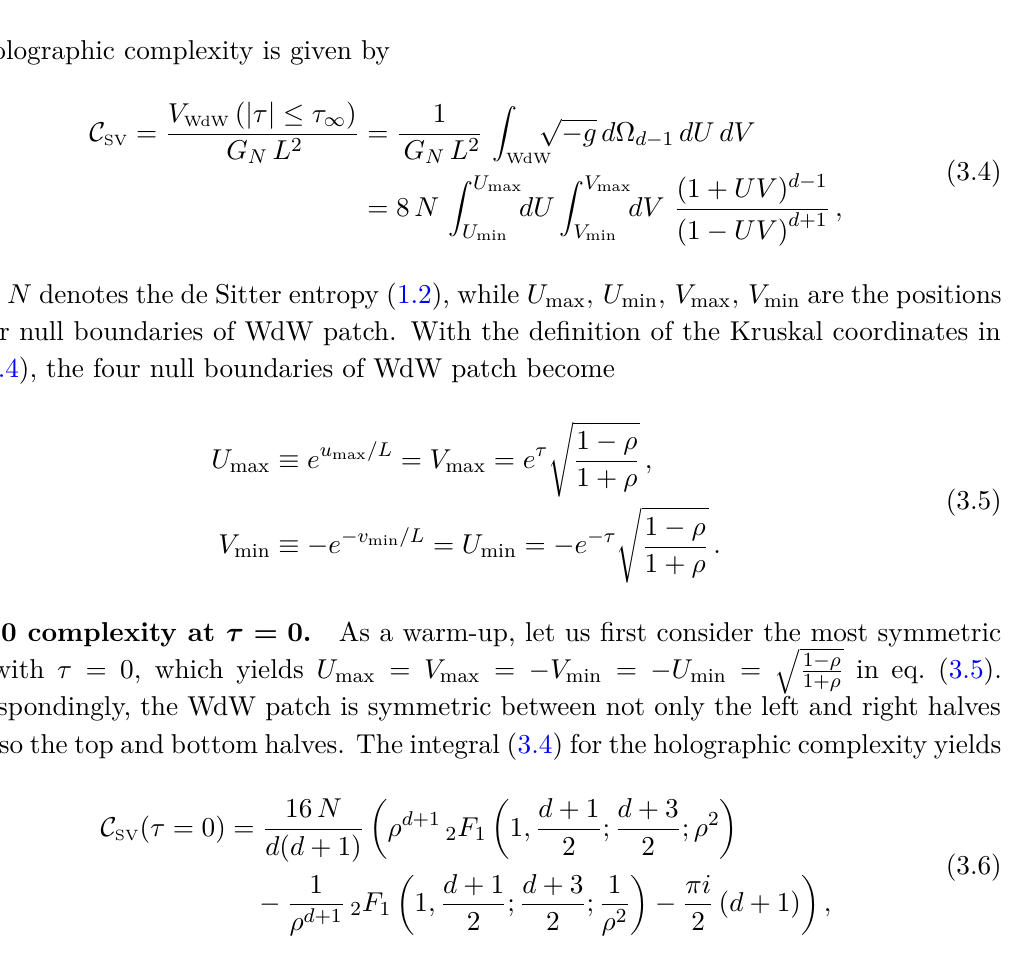
Figure 4 . The time evolution of tip radii r ± of WdW patch with ρ = 1 / 2 . Hence from eq. (3.2), r + diverges at τ = τ ∞ ’ 0 . 5493 , and r − diverges at τ = − τ ∞